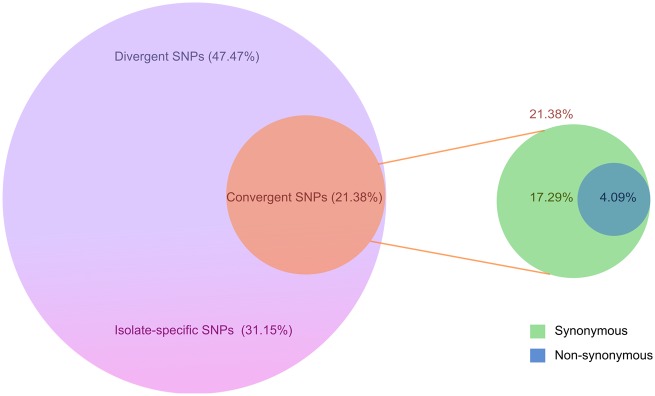
—Various sets of SNPs within the core genome of P. aeruginosa. In a total of 159,609 SNPs, ∼47.47% are divergent—highlighted in violet; 31.15% are isolate-specific—highlighted in pink; and 21.38% are identified in the isolates independent on the phylogenetic background (convergent)—highlighted in orange. The latter SNPs include 17% of synonymous mutations—highlighted in green and 4% of nonsynonymous mutations—highlighted in blue.